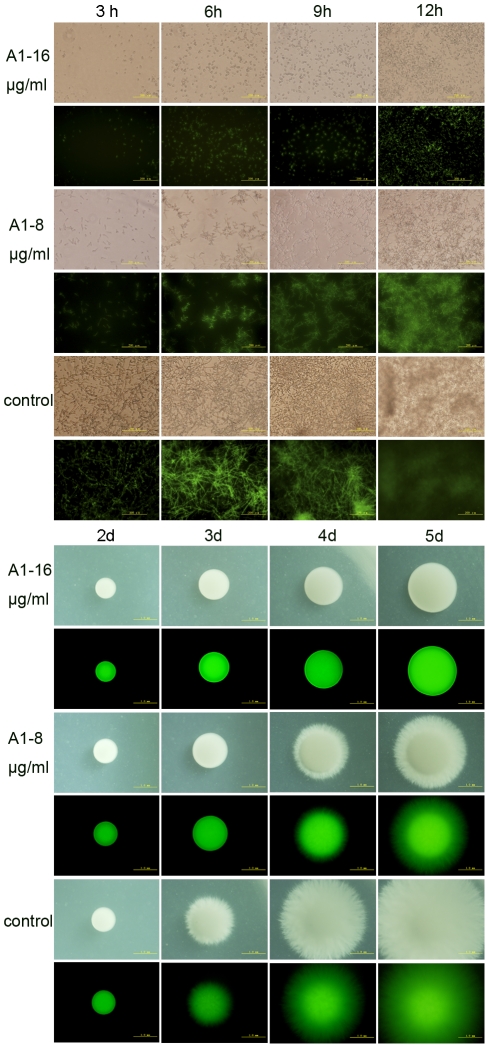
Phase-contrast micrographs of BWP-DPP3-GFP cells challenged by bisbibenzyls compounds within 12 hours.A) Candida albicans cells grown in RPMI 1640 broth medium was captured using an Olympus fluorescent microscope. The results showed that cells co-incubated with A1 (16 µg/ml) displayed yeast cells, cells with no drugs formed mycelium after three hours and maintained substantial growth of hyphae. B) Cells grown on Spider solid media were photographed from 2 d to 5 d using 4× objectives of an Olympus fluorescent microscope.